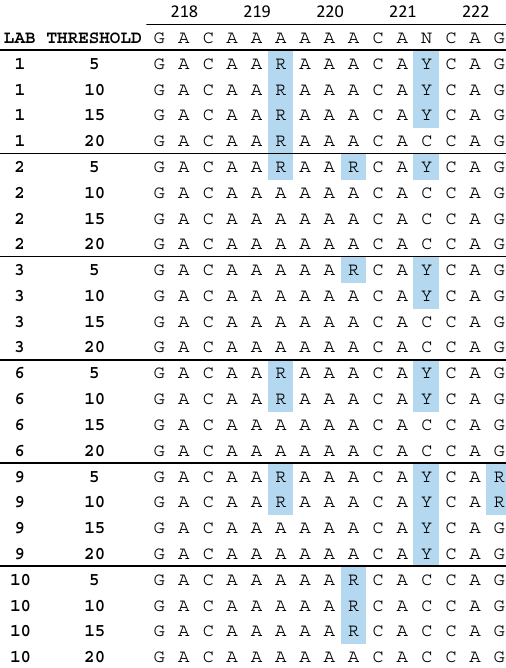
Figure 1. Plots of next-generation sequencing (NGS)-derived PR-RT nucleotide sequence identity vs. VQA Sanger consensus at various thresholds. Each line represents one specimen from panel 24 (24.1 through 24.5) or 26 (26.1 through 26.5).